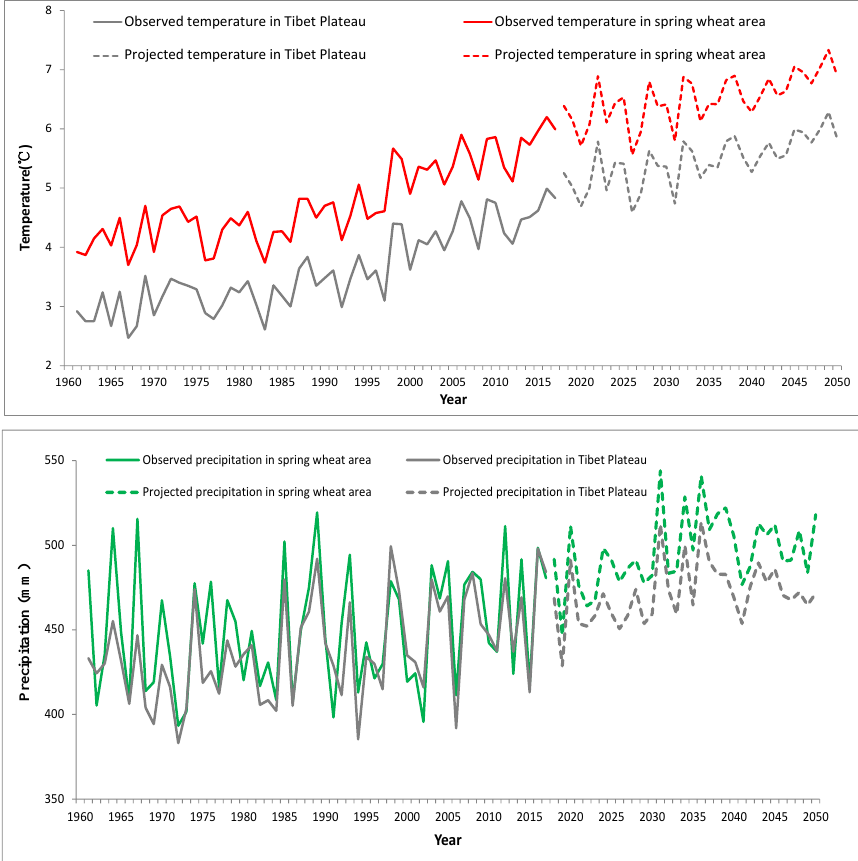
Figure 3. The change of annual temperature and precipitation over wheat area of the Tibetan Plateau